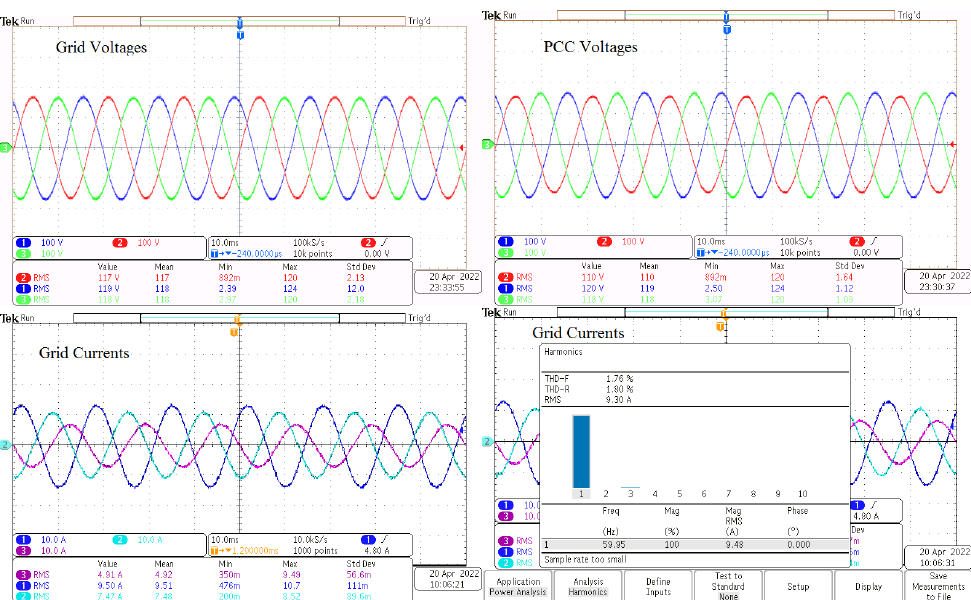
Figure 12. Experimental results before energizing the inverter.